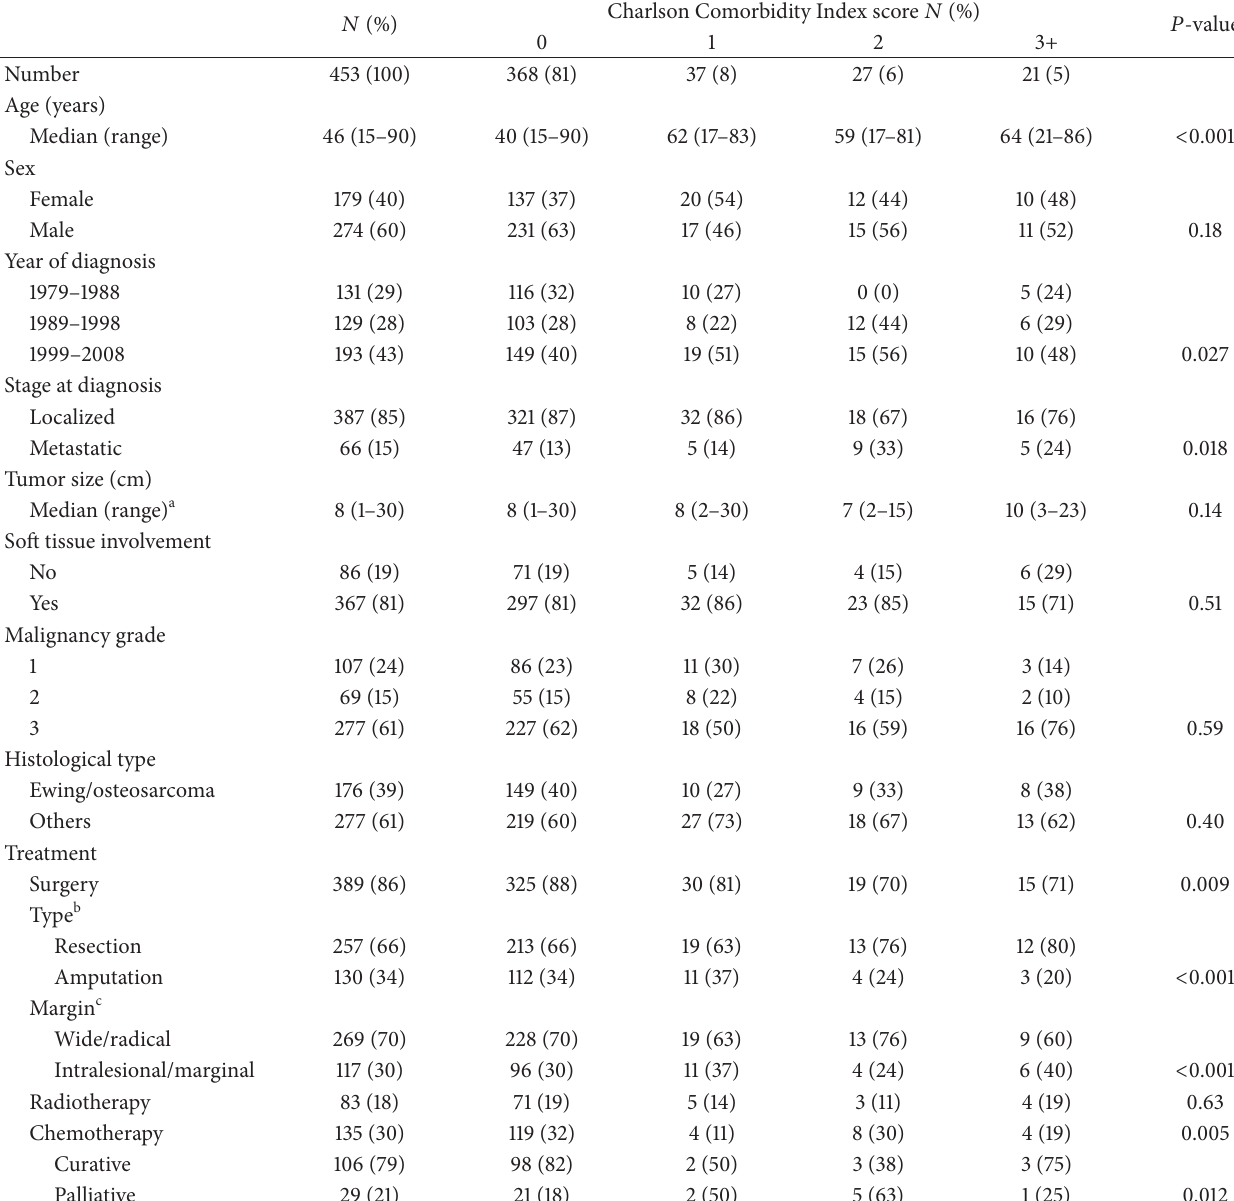
Table 3: Patient characteristics by Charlson Comorbidity Index score (𝑁 = 453)